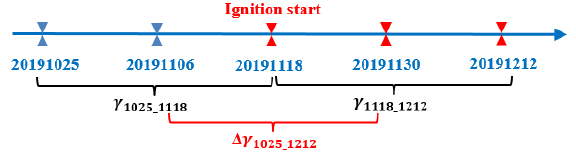
Figure 4. AOI-targeted ignition timeline of SAR imagery